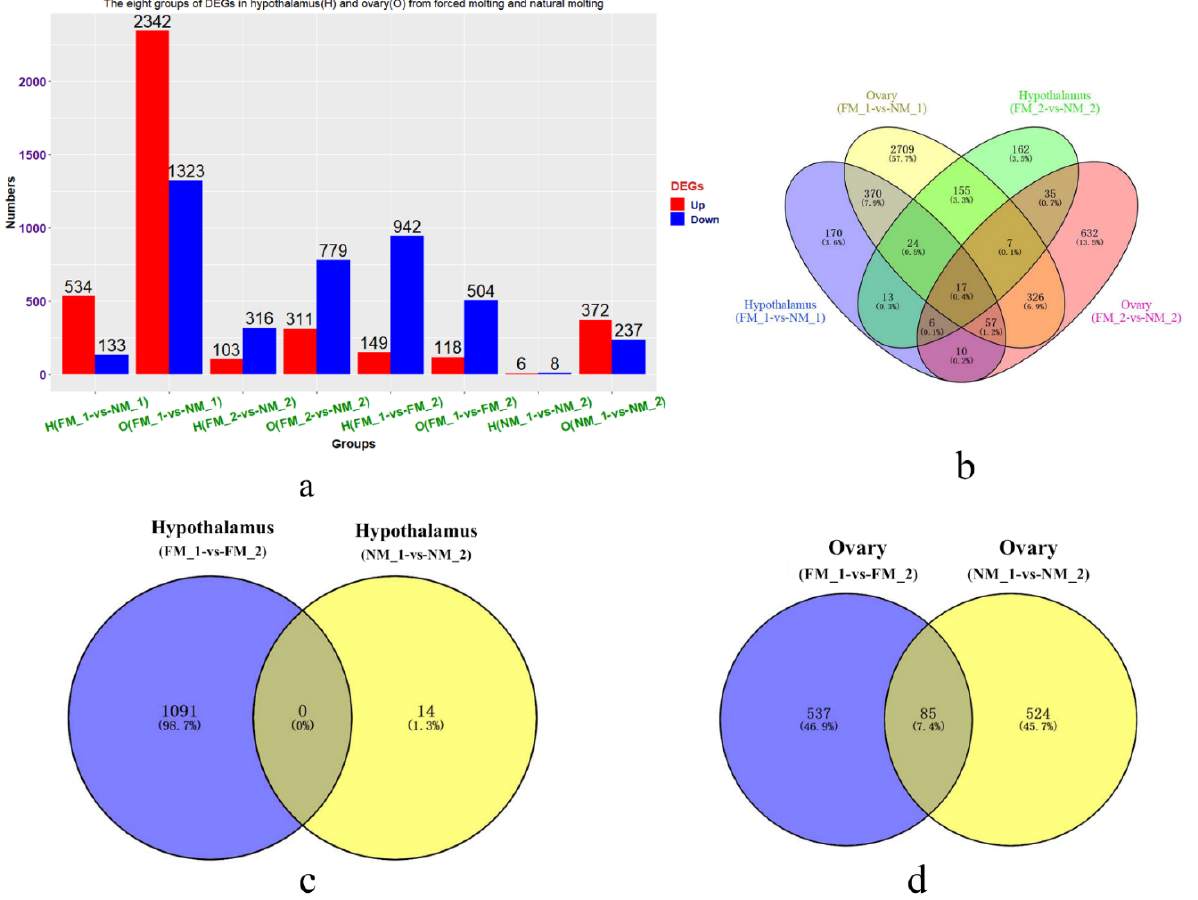
Figure 3. Description of eight groups of DEGs (hypothalamus and ovary from FM_1-vs-NM_1, FM_2-vs-NM_2, FM_1-vs- FM_2, and NM_1-vs- NM_2 groups). The numbers of DEGs in hypothalamus and ovary of forced molted and natural molted hens ( a ), The red indicates the significantly upregulated genes, and the blue indicates the significantly downregulated genes. The Venn diagram of four groups of DEGs from the same molting periods for the two different molting patterns ( b ). The Venn diagram of DEGs in the hypothalamus ( c ) and ovary ( d ) in the FM_1-vs- FM_2 and NM_1-vs- NM_2